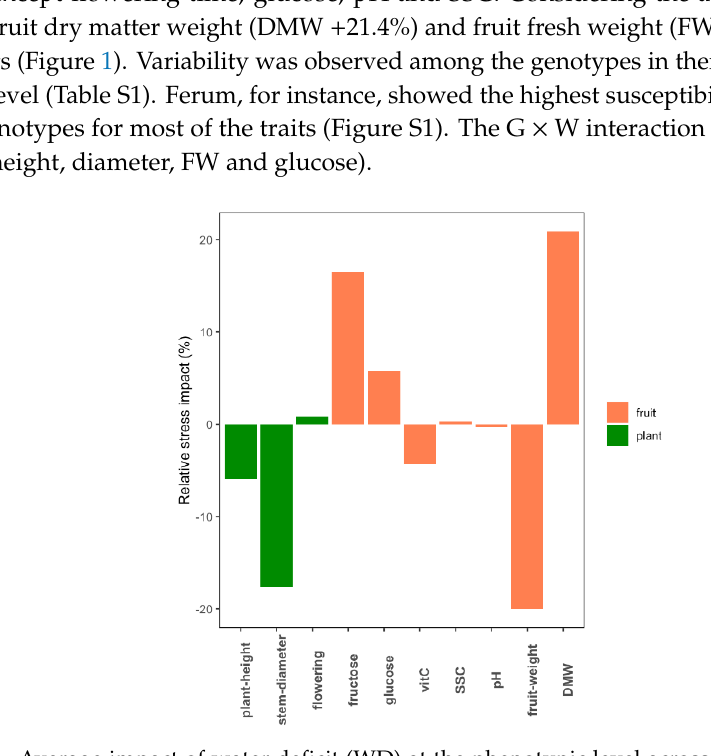
Figure 1. Average impact of water deficit (WD) at the phenotypic level across the eight genotypes. The bar plots indicate for each trait the proportion by which WD decreased/increased the average value of the eight genotypes.